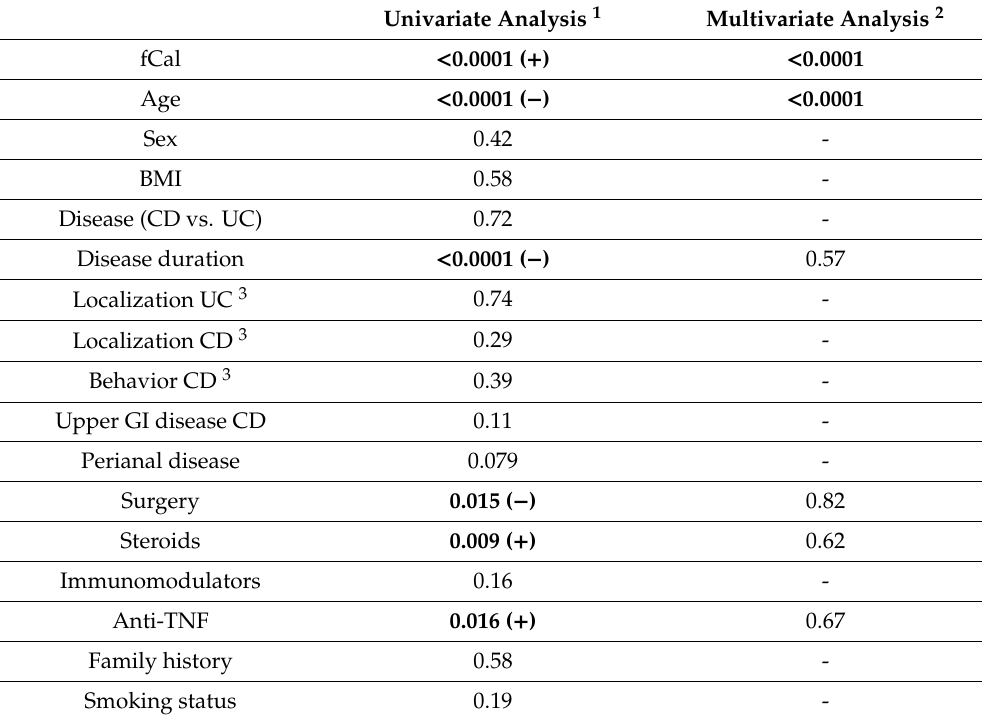
Table 5. Univariate and multivariate analyses of factors with potential influence on